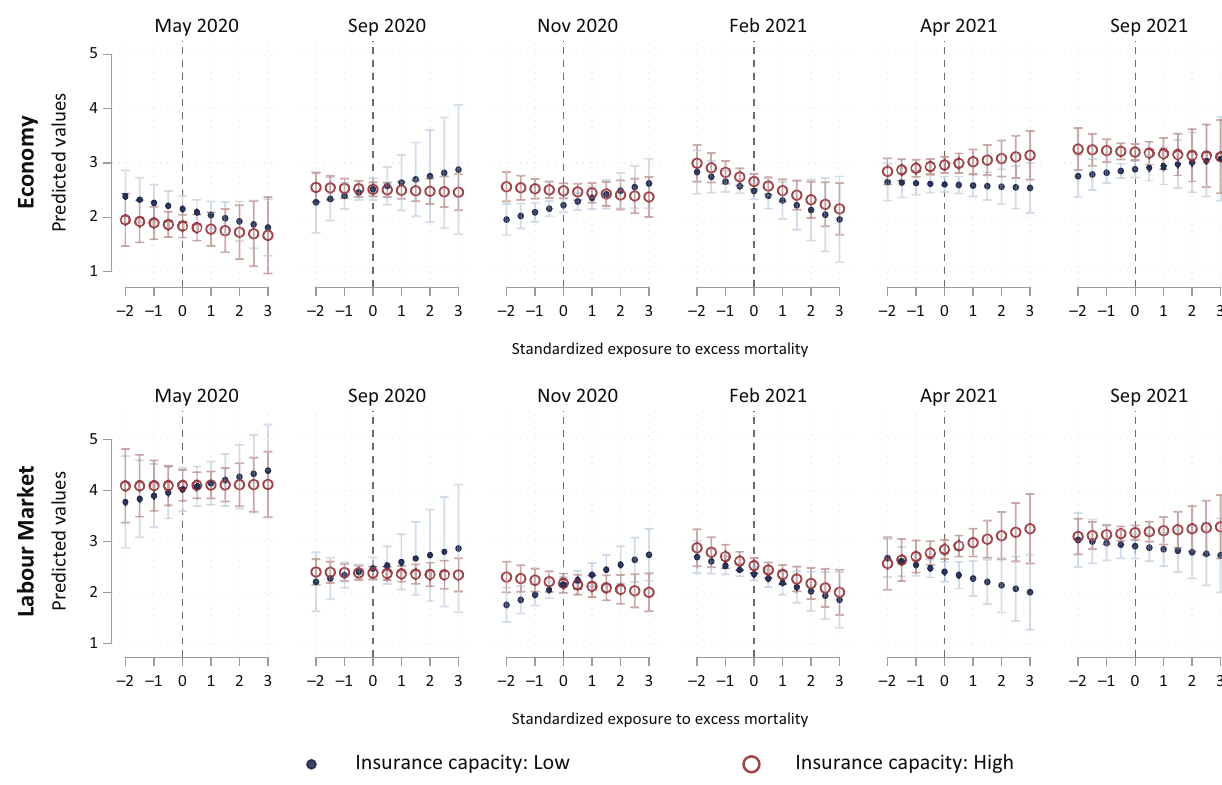
Figure 6. Predicted levels of dispositional optimism from linear mixed models for individuals with low insurance capacity of wealth and high insurance capacity of wealth, conditional on exposure to excess mortality and over waves (N = 11,350). Note: See Section 3.2 for details about the operationalisation of the insurance capacity of wealth. Source: Authors’ work based on Bank of Italy (2022); Istat